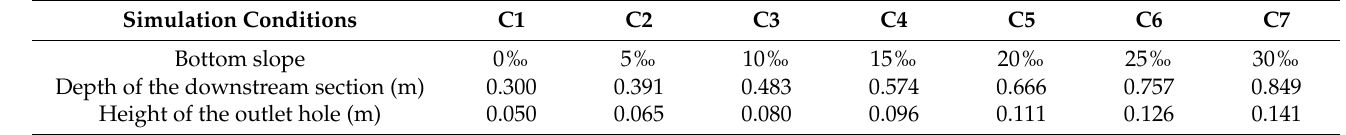
Table 4. Simulation conditions of different bottom slopes and different reservoir